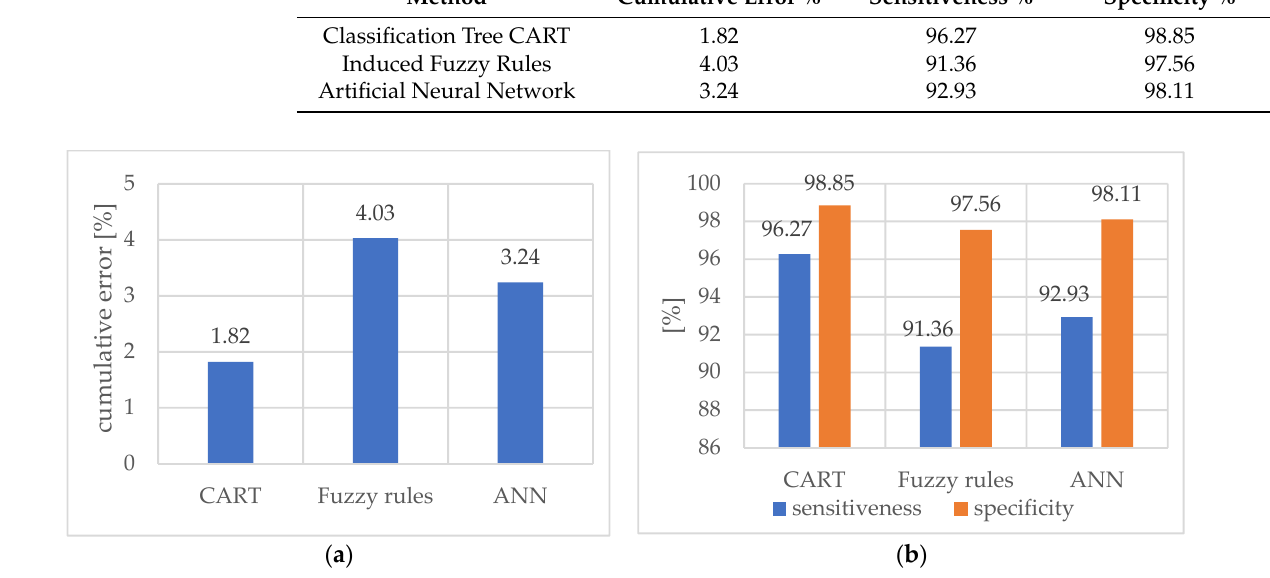
Figure 13. Comparison of cumulative error ( a ), sensitiveness, and specificity ( b ) (considering the cutting parameter v c ). Table 3. Final results of three classification methods (considering the cutting parameter v c ).